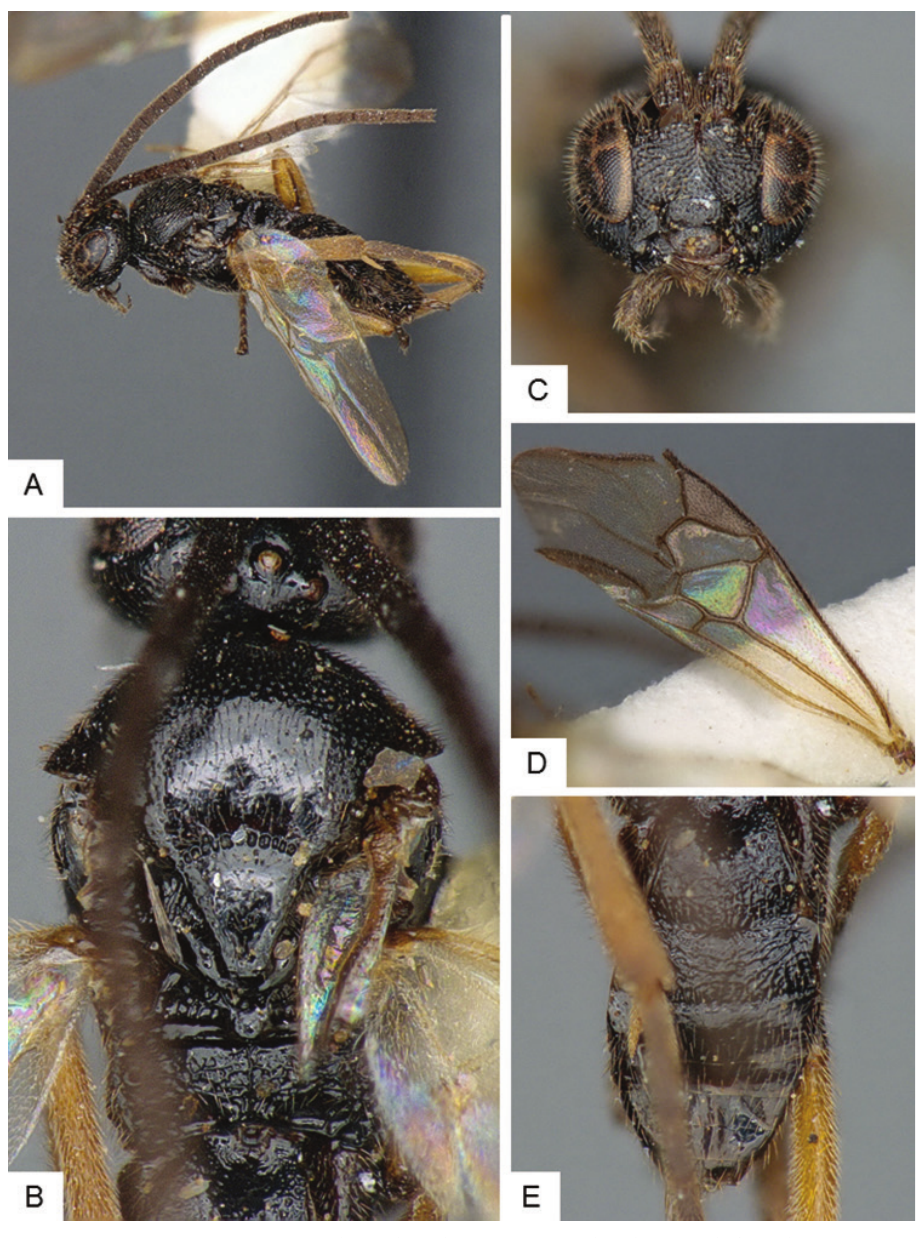
Figure 23. Microgaster sp. 1. A Habitus, lateral B Mesosoma, dorsal C Head, frontal D Fore wing E Metasoma (partially),